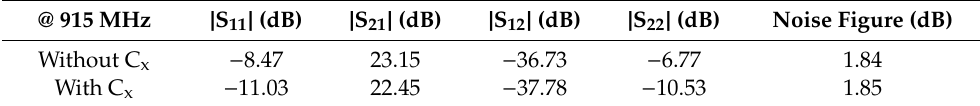
Figure 5. Proposed two-stage low-noise amplifier (LNA) in the radar sensor: ( a ) schematic of the LNA including external bond-wire inductances, and discrete and pad capacitances; ( b ) photograph of the fabricated LNA. Table 3. Simulation results of the proposed LNA at 915 MHz. Table 3. Simulation results of the proposed LNA at 915 MHz.